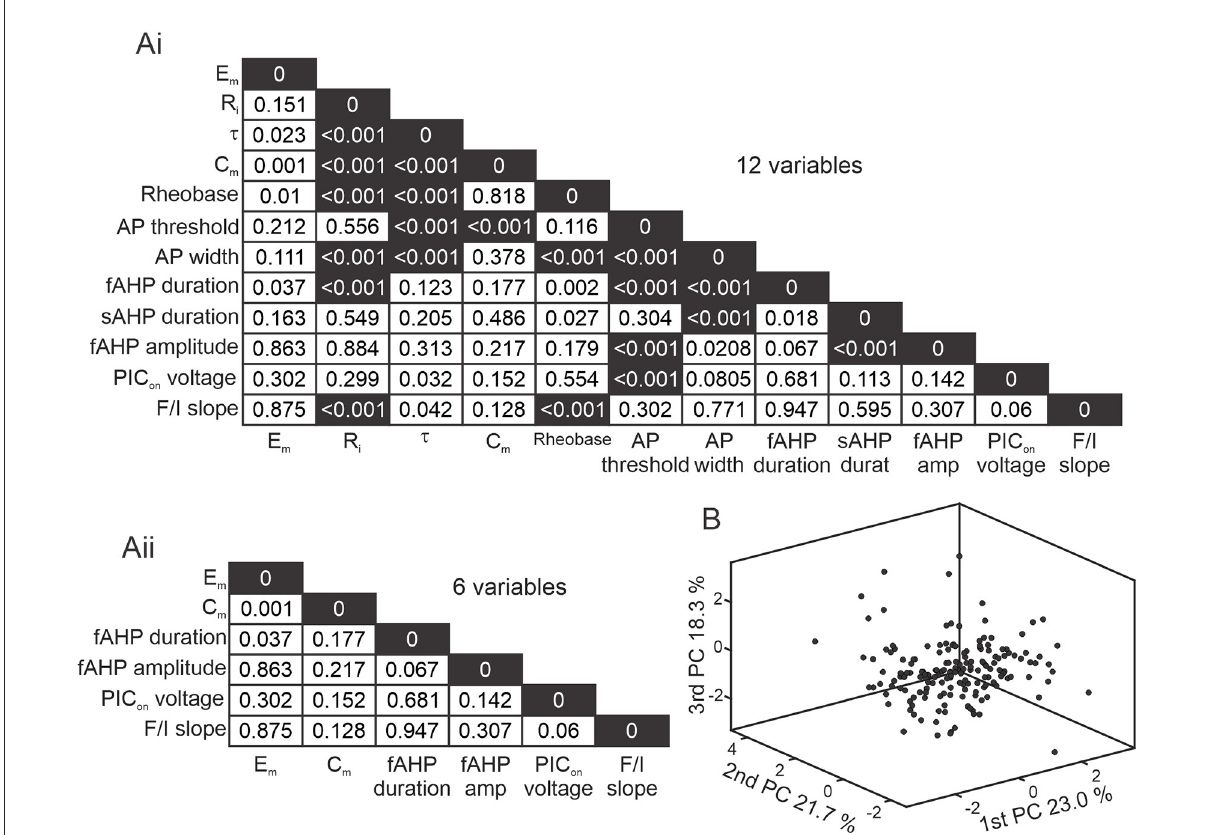
FIGURE2 Reducing dimensionality of electrophysiological properties. (A) Correlation matrix of p -values from a Pearson’s linear correlation of 12 (Ai) and 6 (Aii) electrophysiological properties from 143 Shox2 and 28 Chx10 neurons. Dark shading corresponds to highly correlated values ( p < 0.001). (B) Three-dimensional representation of all 171 neurons included (black dots) after performing principal component analysis (PCA). X axis is the 1 st principal component (PC), Y axis is the 2 nd PC, and Z axis is the 3 rd PC, representing 23.0%, 21.7% and 18.3% of the variability, respectively.